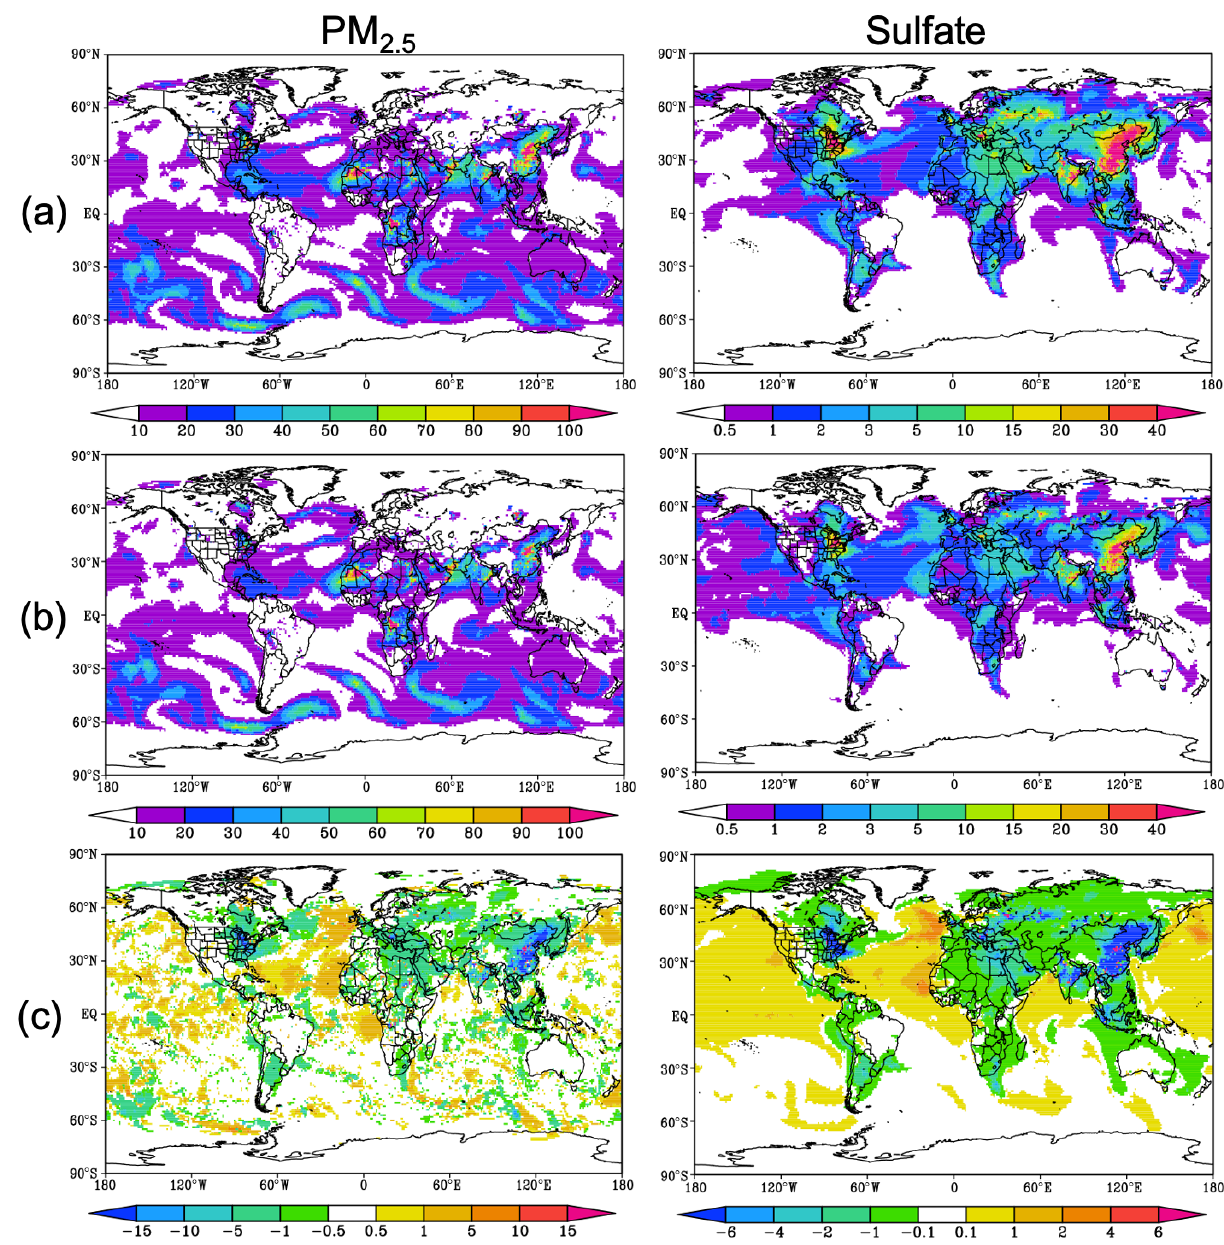
Figure 2. The 5d forecast starting from 00:00UTC on 29 July 2016 of surface PM 2 . 5 and sulfate using (a) GOCART and (b) RACM_GOCART schemes, and their (c) differences (RACM_GOCART minus GOCART) at 00:00UTC on 3 August 2016. Unit: µgm − 3